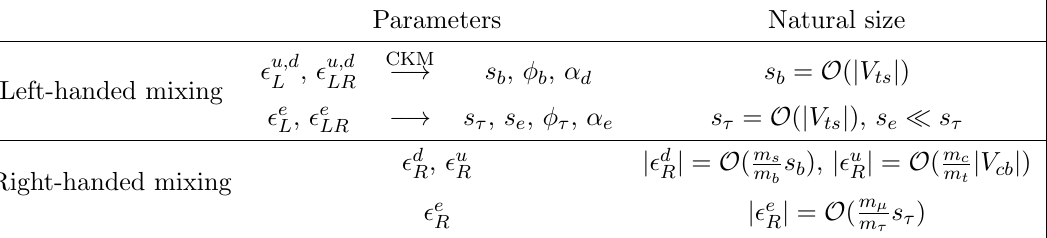
Table 1 . Flavor mixing parameters arising from the U(2) 5 -breaking spurions in the Yukawa sector. The mixing parameters in the left-handed sector ( (cid:15) f ) are parameterized in terms of mixing L;LR angles and phases after removing terms (cid:12)xed by known CKM elements. The parameters (cid:30) (cid:28) , (cid:11) e , and (cid:15) u;d are listed for completeness but are set to zero in the phenomenological analysis since they R play a marginal role (see main